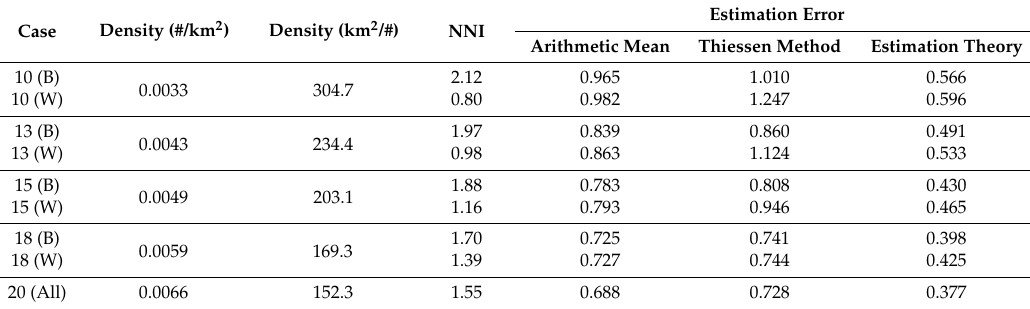
Table 11. Results of the Estimation Error Analysis by Rearranging the Rain Gauge